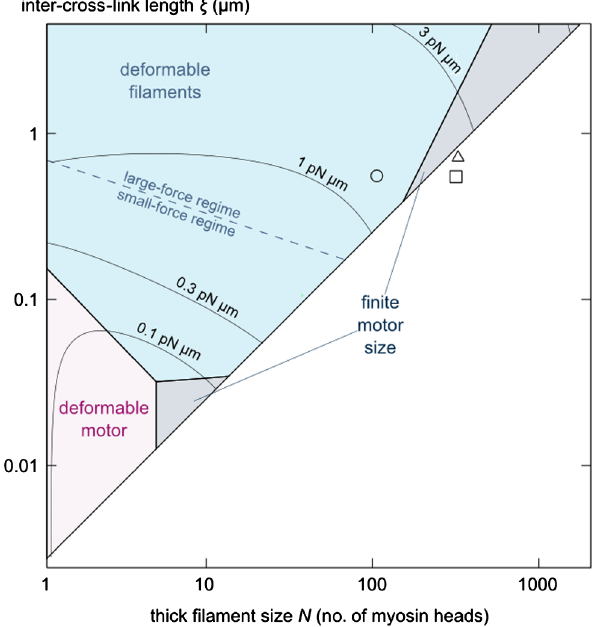
FIG. 5. Contractile forces as a function of experimentally controllable parameters. Colors identify the dominant contraction mechanism in each parameter regime. Contours indicate the magnitude of the contractile force dipole per myosin head h D i =N . Symbols indicate the in vitro experimental regimes of Ref. [16] (circle), Refs. [15,33] (square) and Ref. [34]